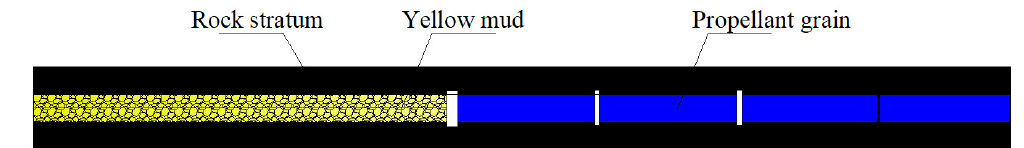
Figure 8. Schematic diagram of charging and sealing structure.